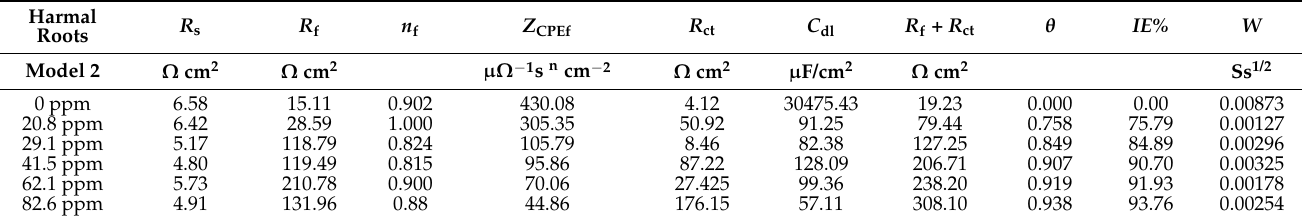
Table 2. Impedance parameters for the Harmal roots extract on the C-steel in 0.25 M H 2 SO 4 medium by fitting the equivalent circuit model 2.